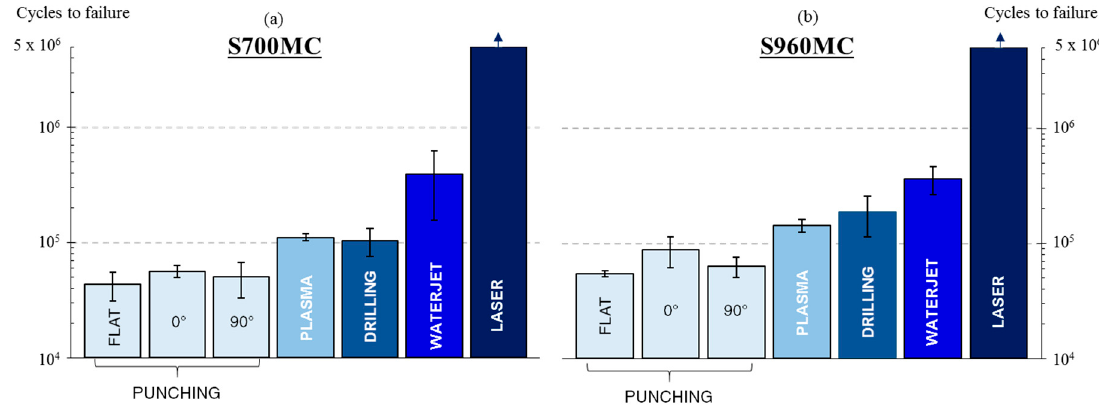
Figure 17. Fatigue results for ( a ) S700MC and ( b ) S960MC.